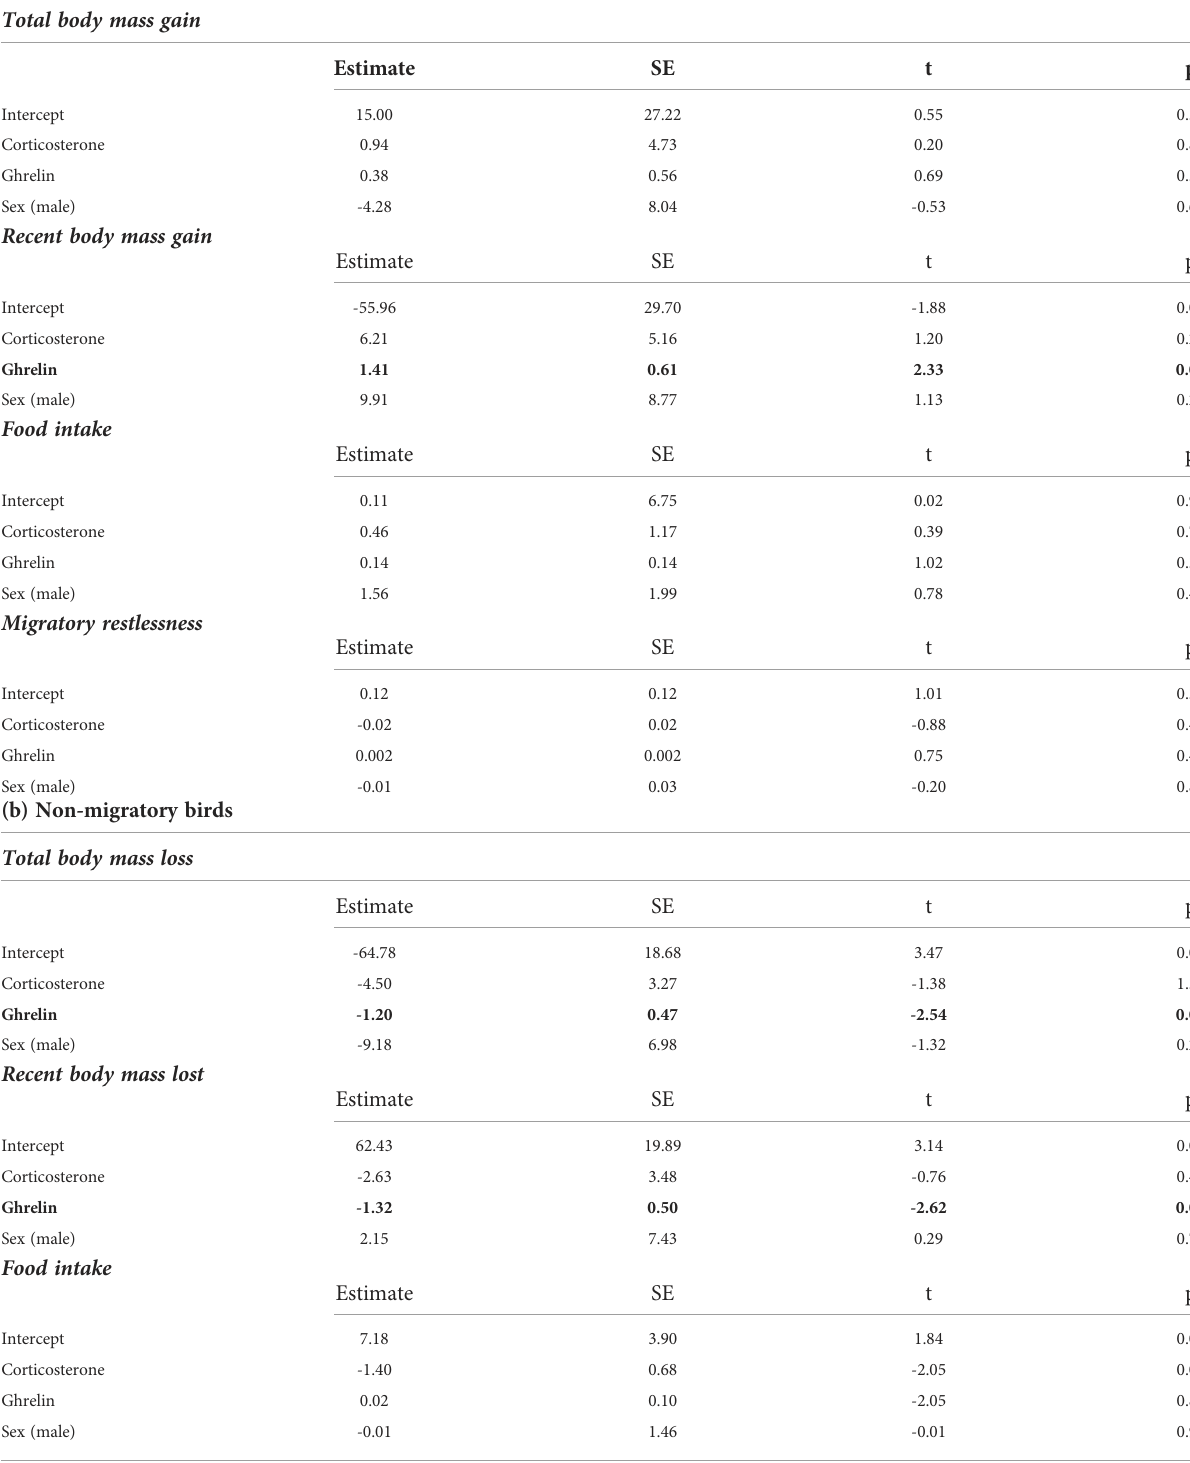
TABLE 2 Results of GLMs, separately by sampling group, assessing the effects of plasma corticosterone, plasma ghrelin and sex on migratory status assessed through changes in body mass, levels of food intake and migratory restlessness (for full details on study design see Material and